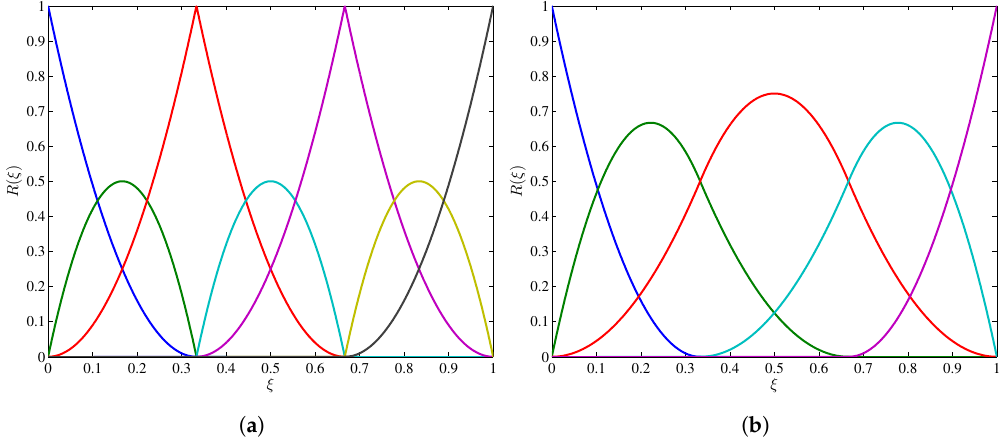
Figure 1. ( a ) C 0 continuity quadratic NURBS basis functions from knot vector Ξ = { 0,0,0,1/3,1/3,2/3,2/3,1,1,1 } ; and ( b ) C 1 continuity quadratic NURBS basis functions from knot vector Ξ = { 0,0,0,1/3,2/3,1,1,1